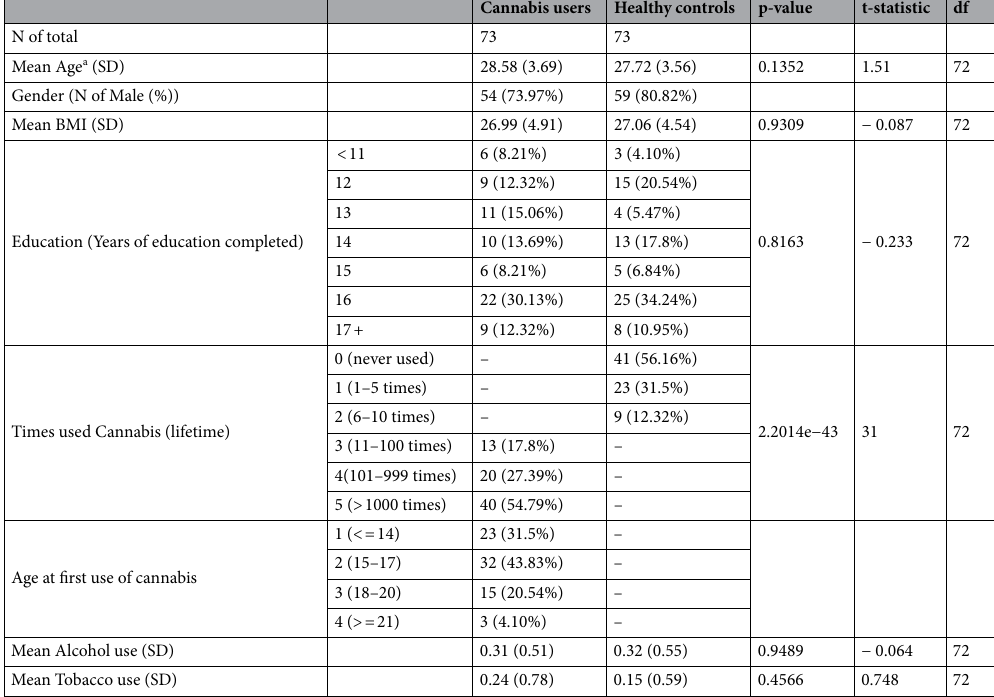
Table 1. Summary of socio-demographic and substance use characteristics of the subjects included in the study. a Age range = 22–36